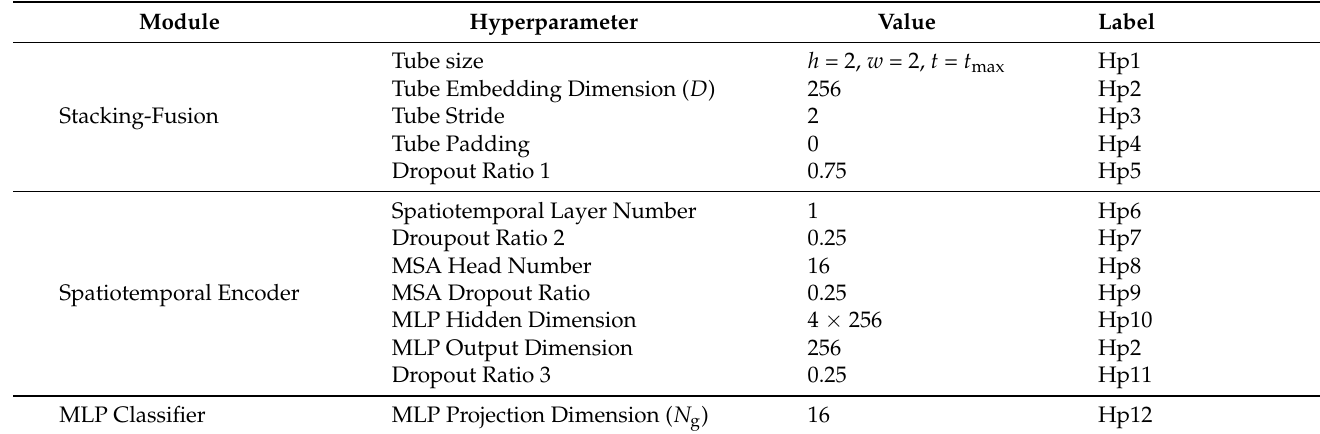
Figure 14. Multi-step learning-rate scheduler. Table 5. Structure, hyperparameters, and their value and hyperparameter labels of